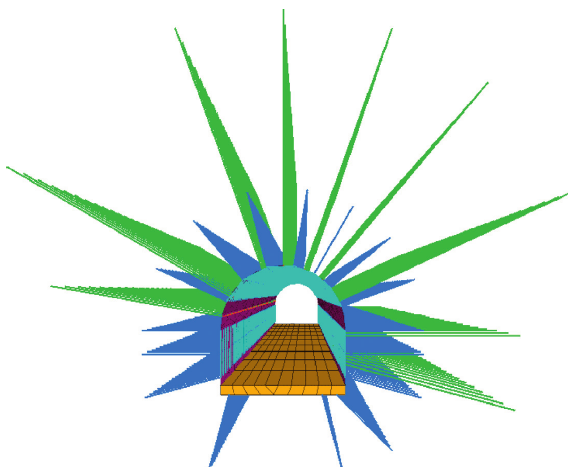
Figure 10: Optimized support